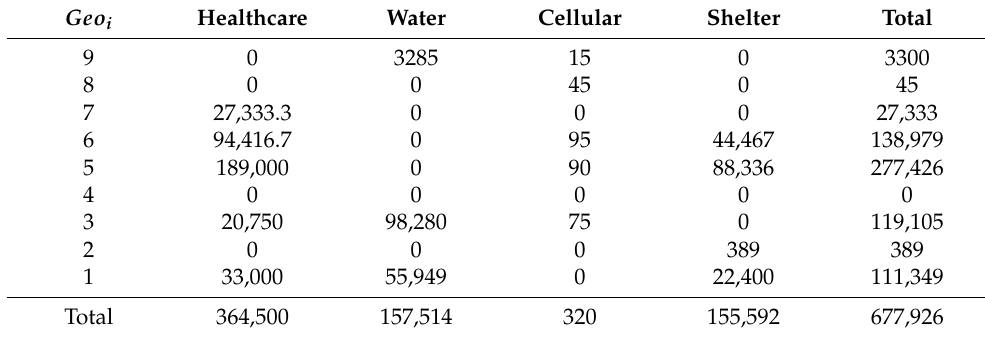
Table 9. Total power demand for every zone (kWh).